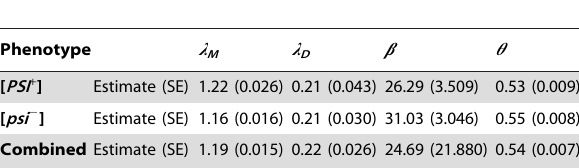
Table 3. Parameter estimates from fitting the mother- daughter gamma distributions to the cell reproduction data for the YJW512 [ PSI + ] and [ psi 2 ] strains grown in